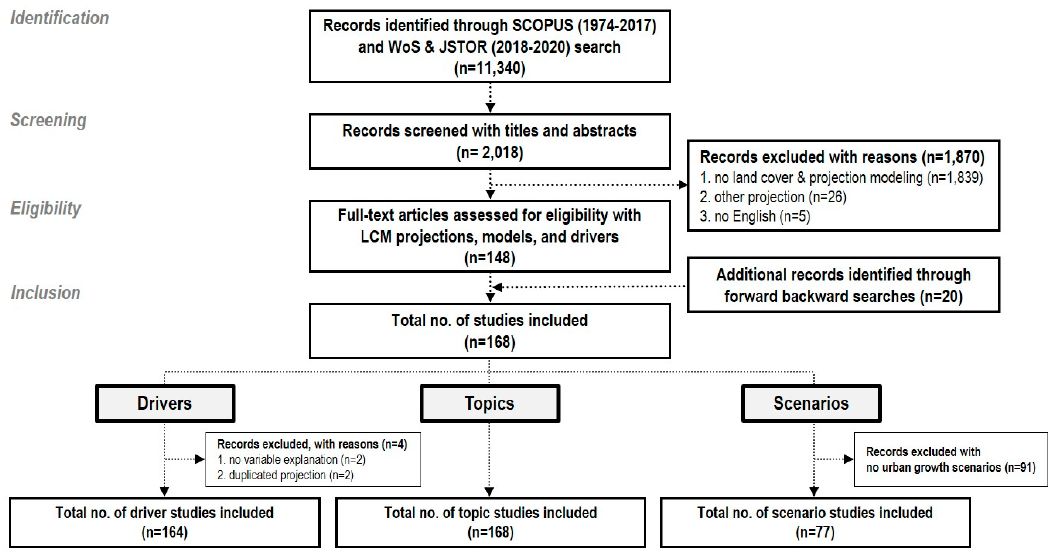
Figure 1. Urban Land Change Modeling (LCM) literature search and evaluation for inclusion (modified from Xiao and Watson (2019) [17]).